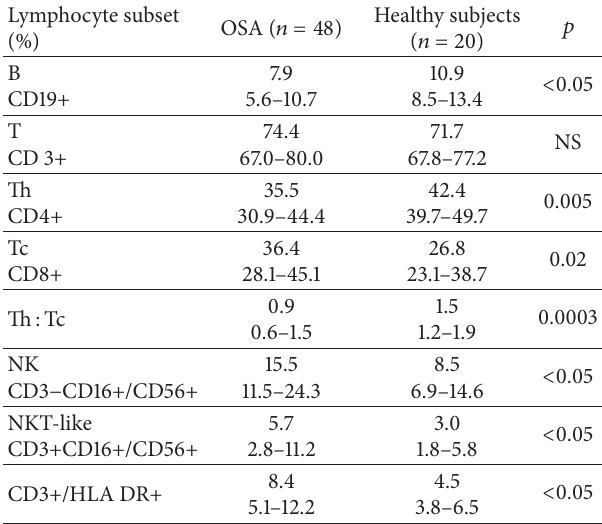
Table2:ProportionoflymphocytesubtypesandCD4+ : CD8+ratio in the peripheral blood of patients with OSA and healthy subjects. Data expressed as median